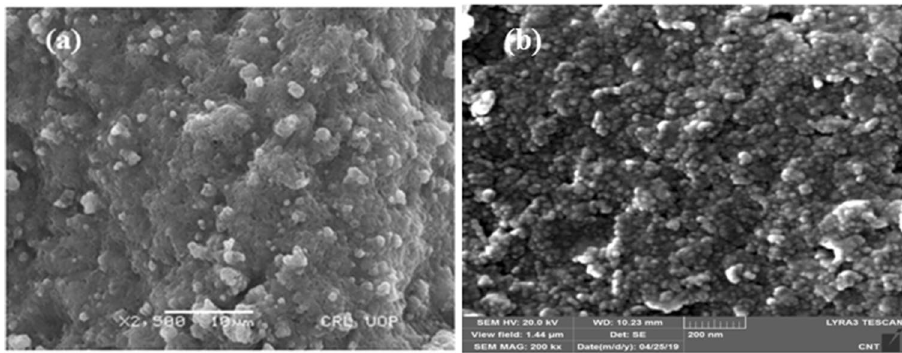
Fig. 1 SEM analysis of a NiO NPs b NiO/Nc NC